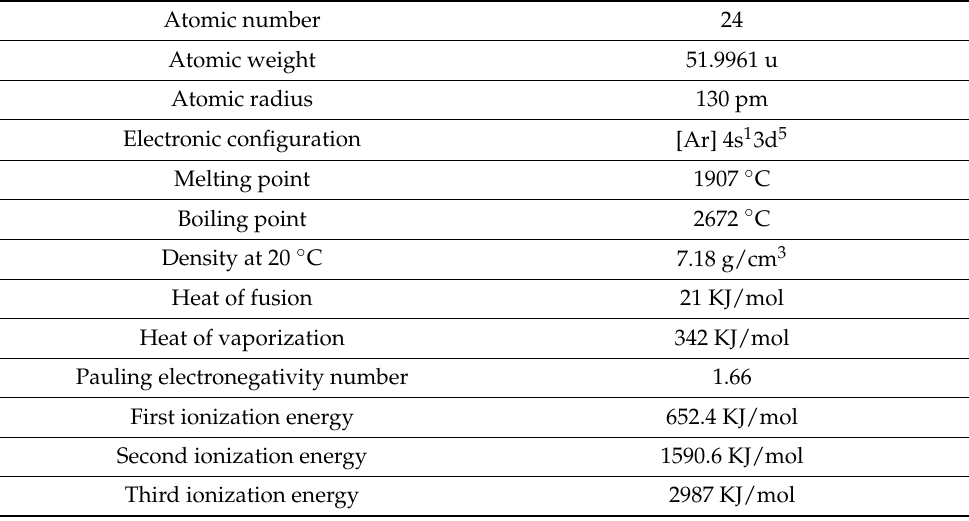
Table 1. Physical and chemical properties of chromium.